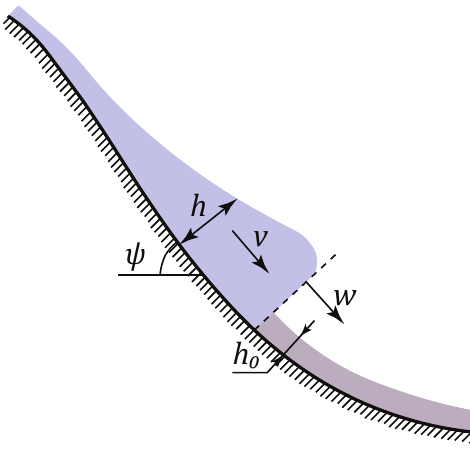
Figure 1. Scheme of the